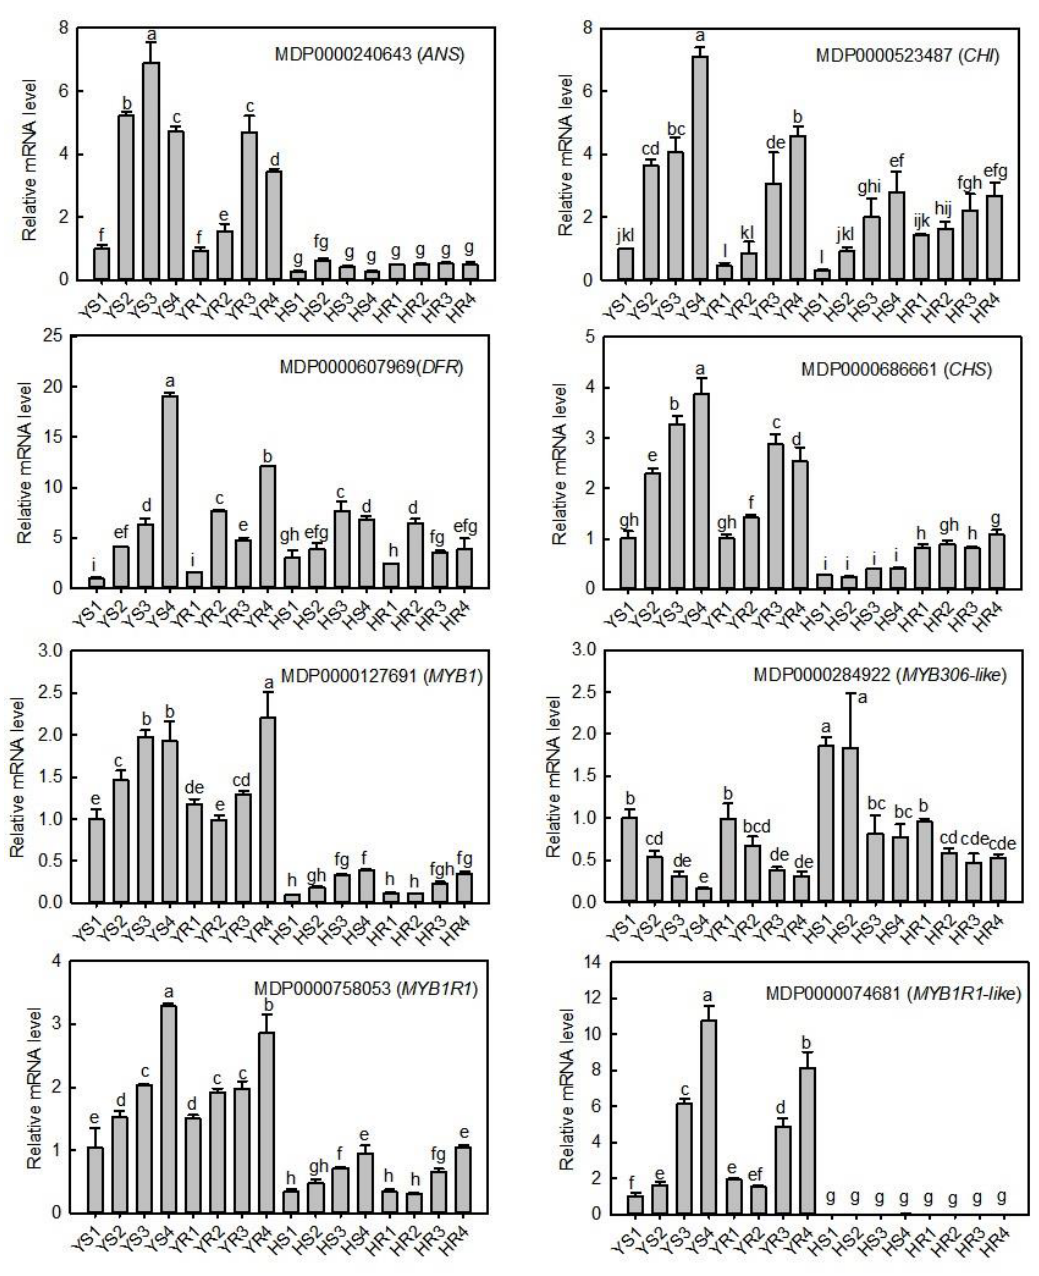
Figure 6. Verification of the expression of candidate structural genes and TFs at different altitudes using qRT-PCR. YS and YR represent Huashuo and Huarui apples, respectively, in the high-altitude orchard; HS and HR represent Huashuo and Huarui apples, respectively, in the low-altitude orchard. YS1, YS2, YS3, and YS4 represent the four color transition periods of YS, and the same rationale was applied to the other samples. Different lowercase letters on the error bar in each graph indicate a significant difference at p < 0.05 according to Duncan’s multiple range test.